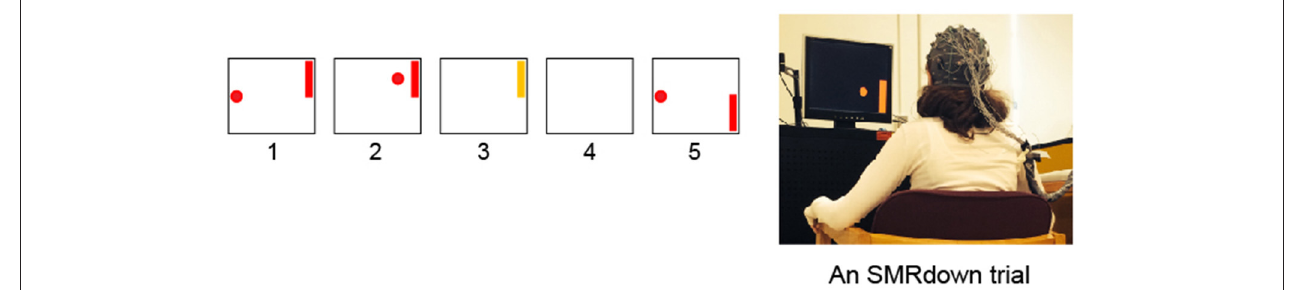
FIGURE 1 | Subjects learn over a series of training sessions to use SMR amplitudes in the µ (8–12Hz) frequency band over left sensorimotor cortex (at/around the C3 or CP3 electrodes) to move a cursor vertically while it moves from left to right at a constant rate (Wolpaw et al., 1991; Wolpaw and McFarland, 1994; McFarland et al., 2003). (1) a target appears; (2) 1s later the cursor appears and moves in two dimensions with vertical movement controlled by the subject’s SMR amplitude; (3) the cursor reaches the target and the target flashes for 1s; (4) the screen is blank for 1s; and then (5) the next trial begins. (If the cursor misses the target, the flash does not occur, the screen simply goes blank for 2s.) In each training session, the participant goes through 10 blocks of ≈ 18 SMR trials each, separated by ≥ 1-min rest periods.